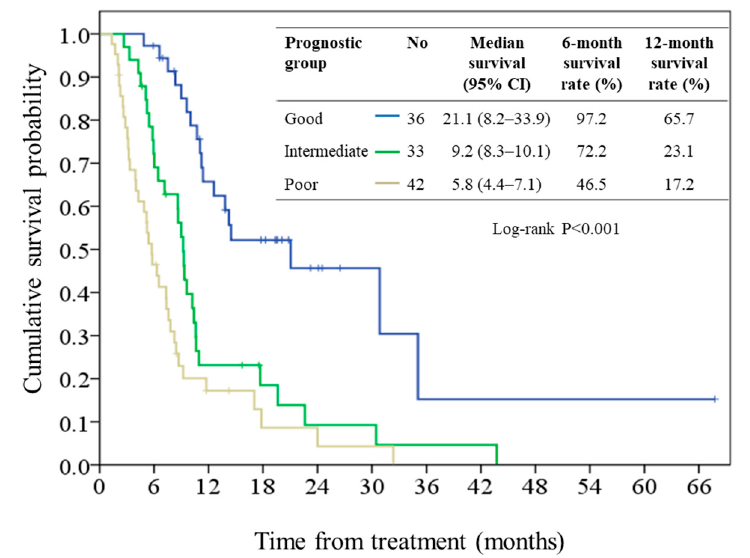
Figure 3. Kaplan-Meier plot of overall survival in patients stratified by prognostic group. CI, confidence interval. Table 4. Survival time of patients by prognostic group.